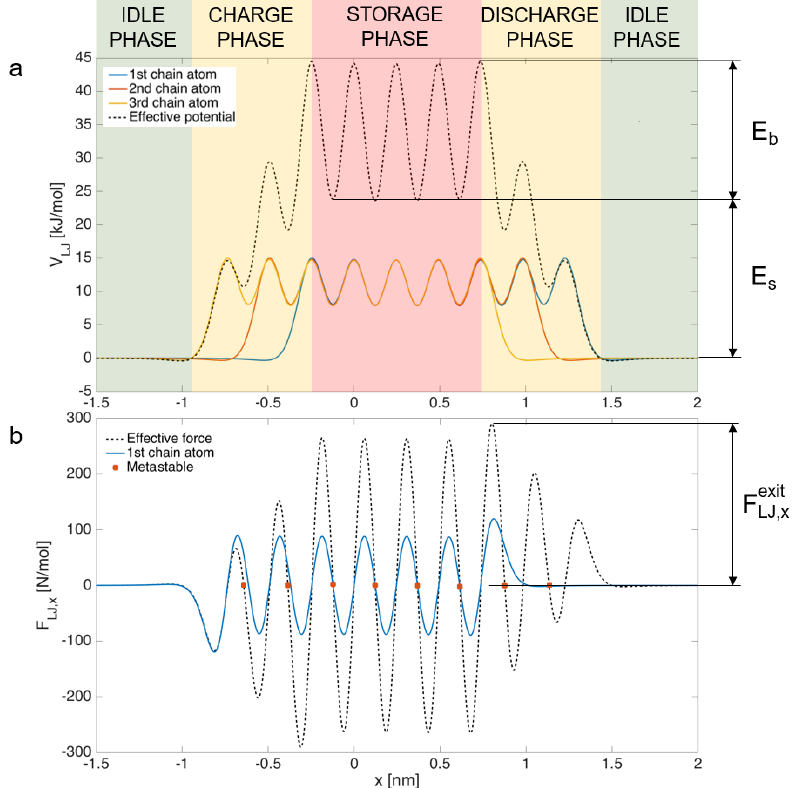
Figure 4. ( a ) Interatomic vdW potential between two chains of carbon atoms. The effective potential (dashed line) is computed from the superimposition of all the interactions between each atom of the sliding and the stationary chains (colored lines); ( b ) VdW force exerted by the stationary chain on the sliding one along the x direction: effective force (dashed line) and contribution given by the first atom of the sliding chain (colored line). Orange dots correspond to metastable equilibrium